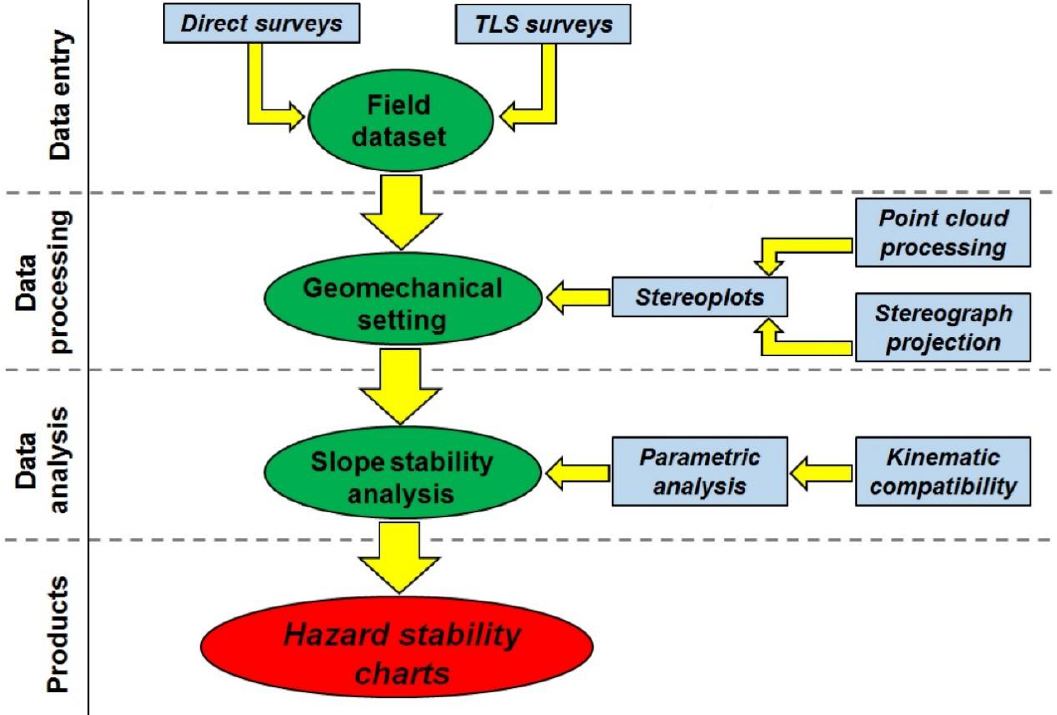
Figure 1. Flow chart of the applied methodology, which is based on data from direct and Terrestrial Laser Scanning (TLS) surveys.